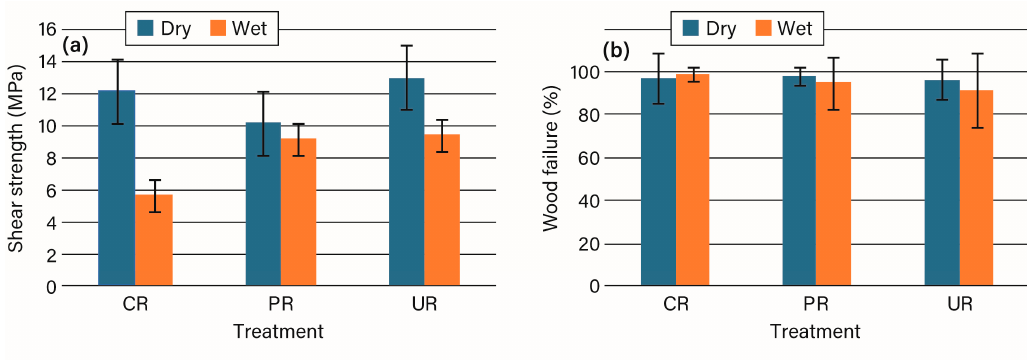
Figure 2. The ( a ) shear strength and ( b ) percentage wood failure for resorcinol-formaldehyde bonding of unmodified (CR), planed acetylated (PR), and unplaned acetylated (UR) wood.